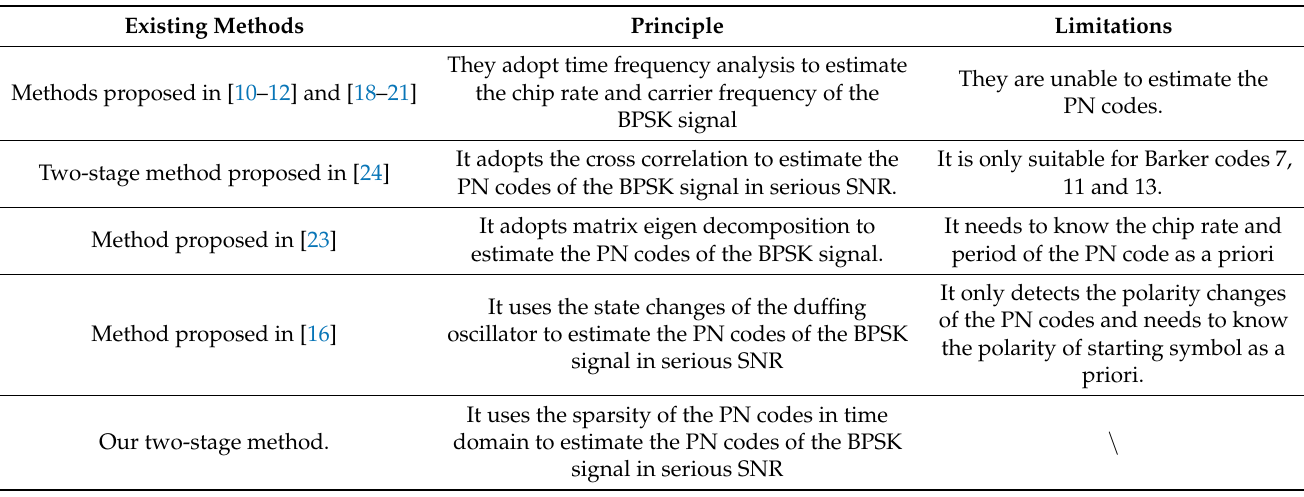
Table 1. Summary of existing methods.